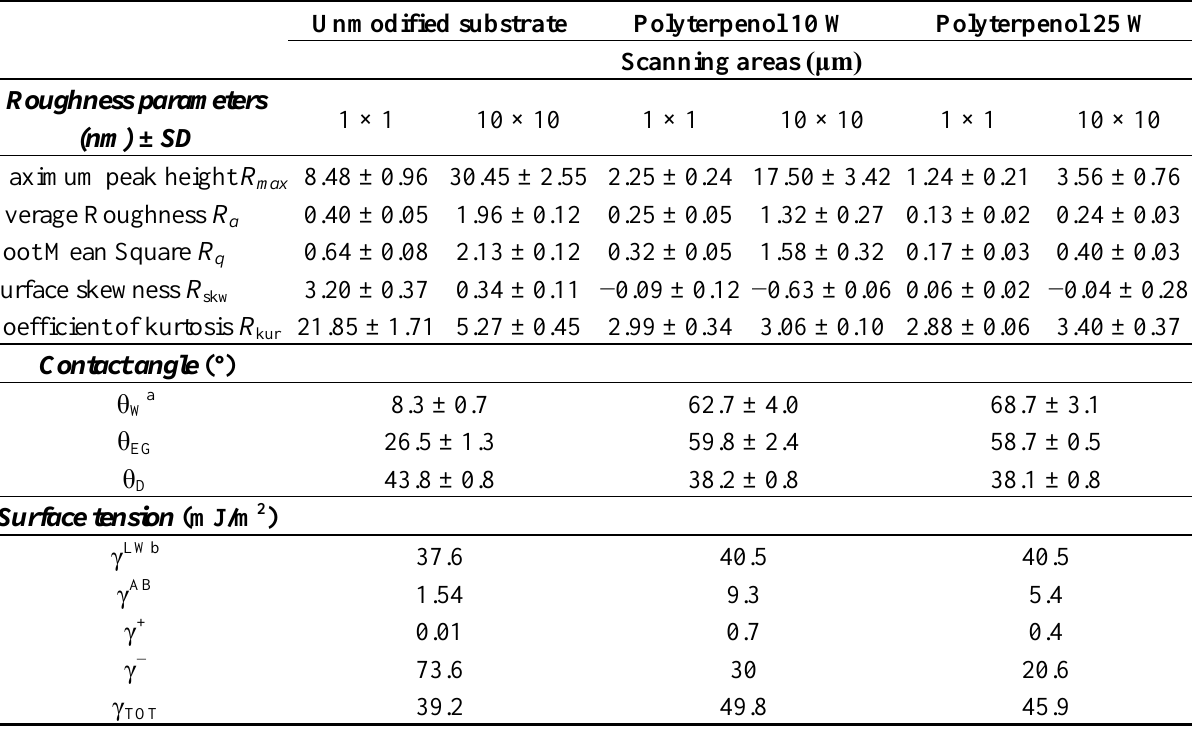
Table 1. Surface hydrophobicity, surface tension, surface free energy, and atomic force microscope (AFM) analysis of the roughness parameters for the modified and substrate (glass)